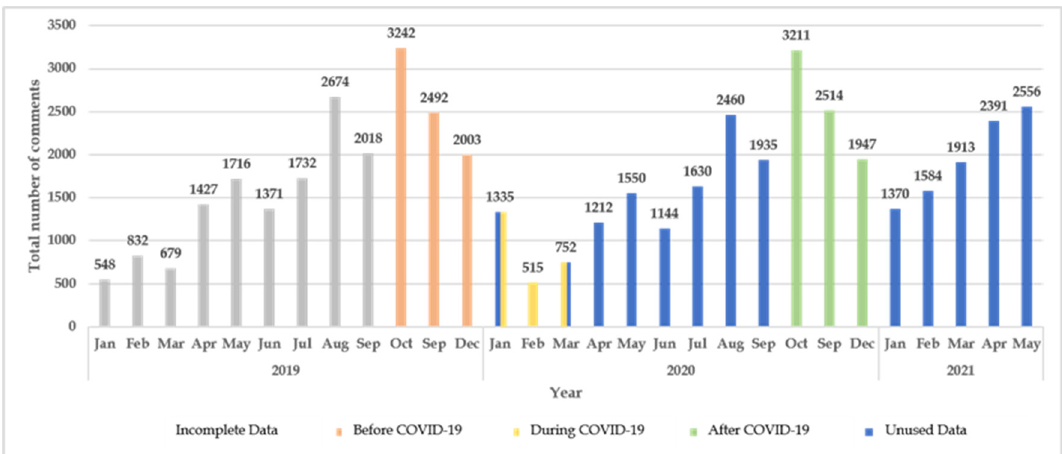
Figure 3. Statistic of data captured from Ctrip.com and data used in three comparative